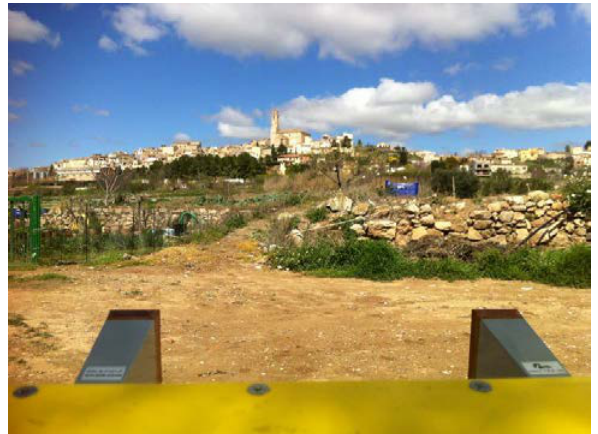
Figure 1. Picture of Barberà de la Conca (Spain) seen from the GBSAR viewpoint.